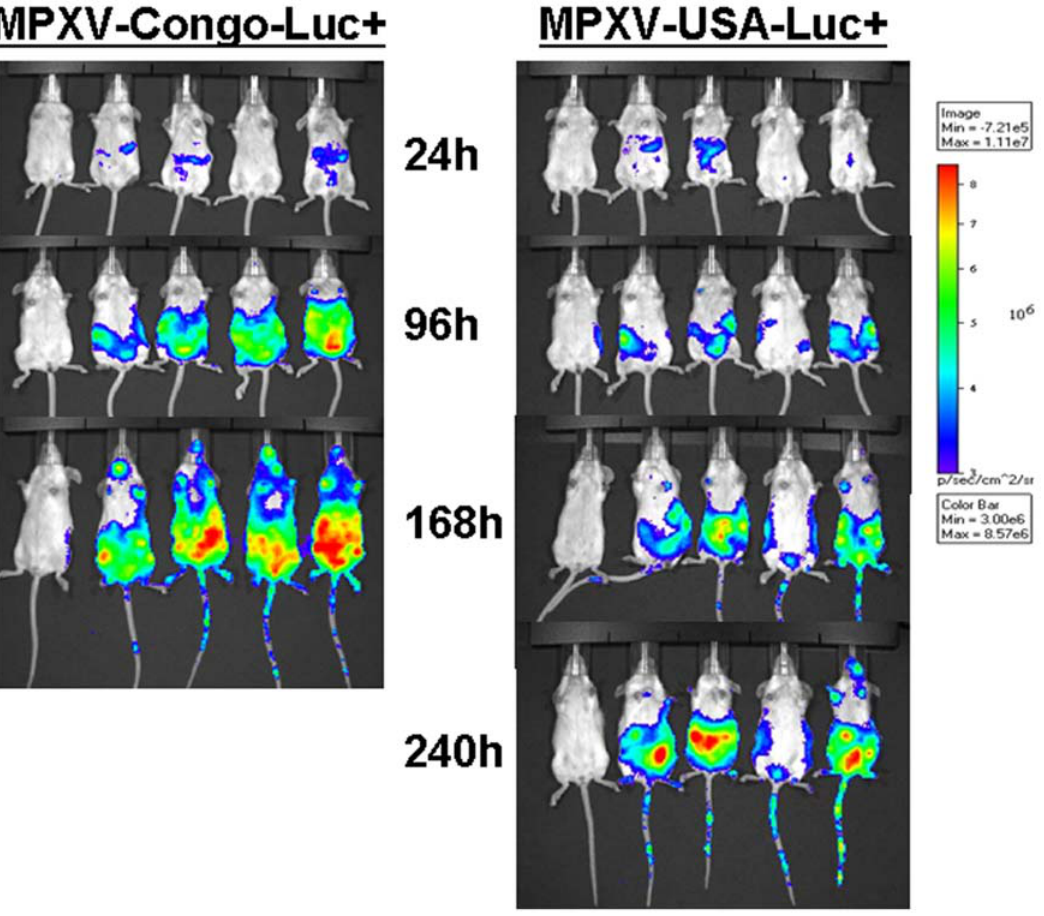
Figure 3. In vivo imaging of MPXV-Congo-Luc + (left panel) and MPXV-USA-Luc + (right panel) in SCID- BALB/c mice (Intraperitoneal inoculation). A group of four, 4-week-old SCID BALB/c mice was inoculated by the IP route with 105 PFU of MPXV-USA-Luc + virus and imaged as described as described in materials and methods. An uninfected negative control animal (on left) was also injected with luciferin and imaged on the same times as infected animals. Ventral